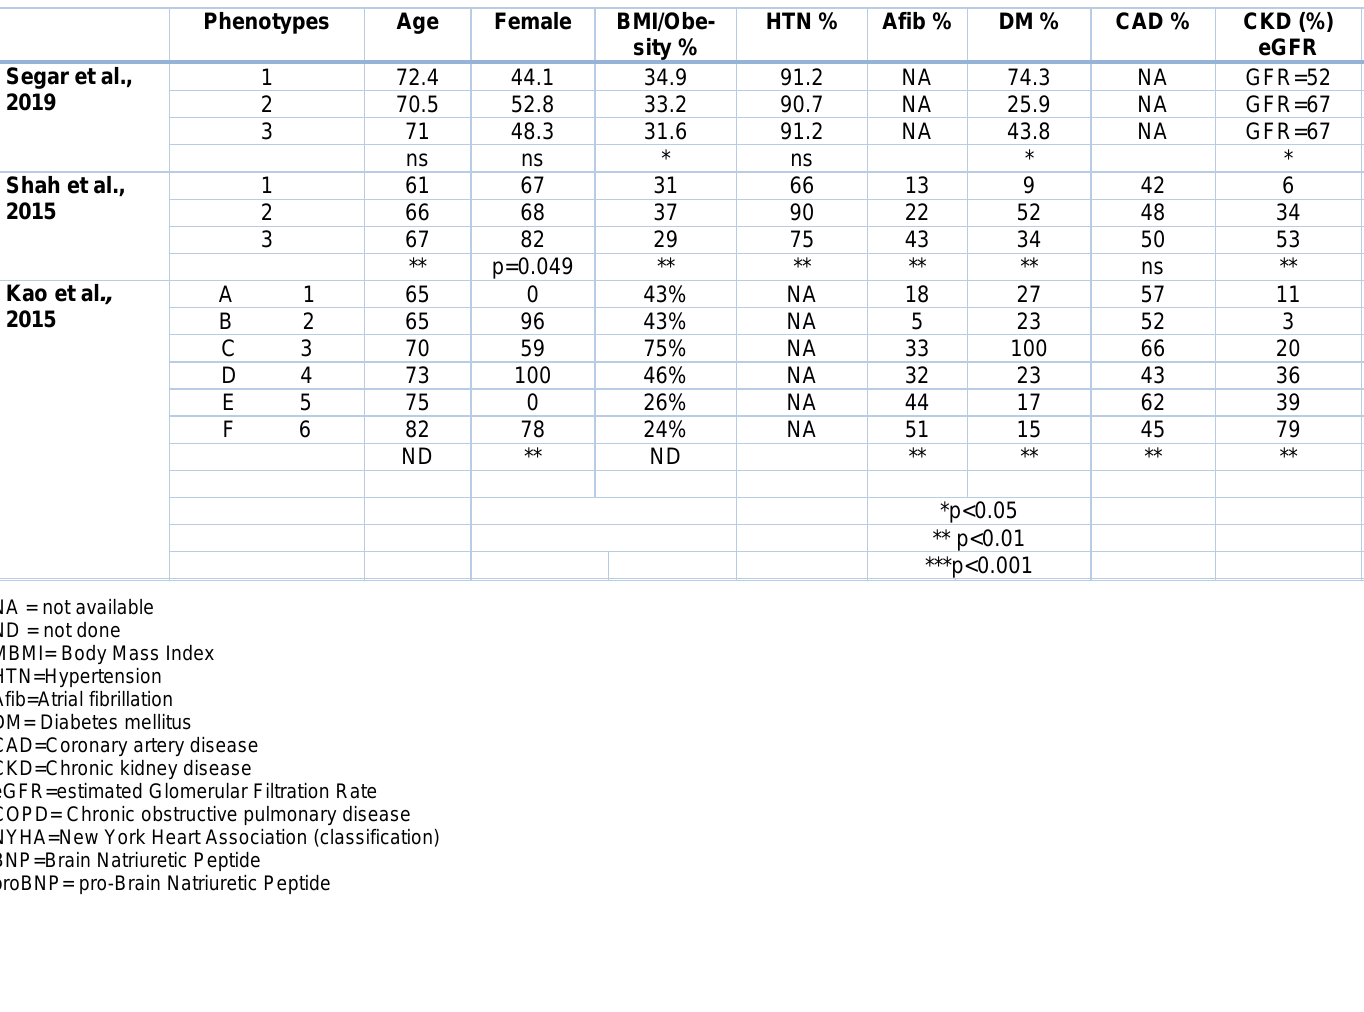
Table 2 (cont.): Clinical characteristics of each phenotype in the ten